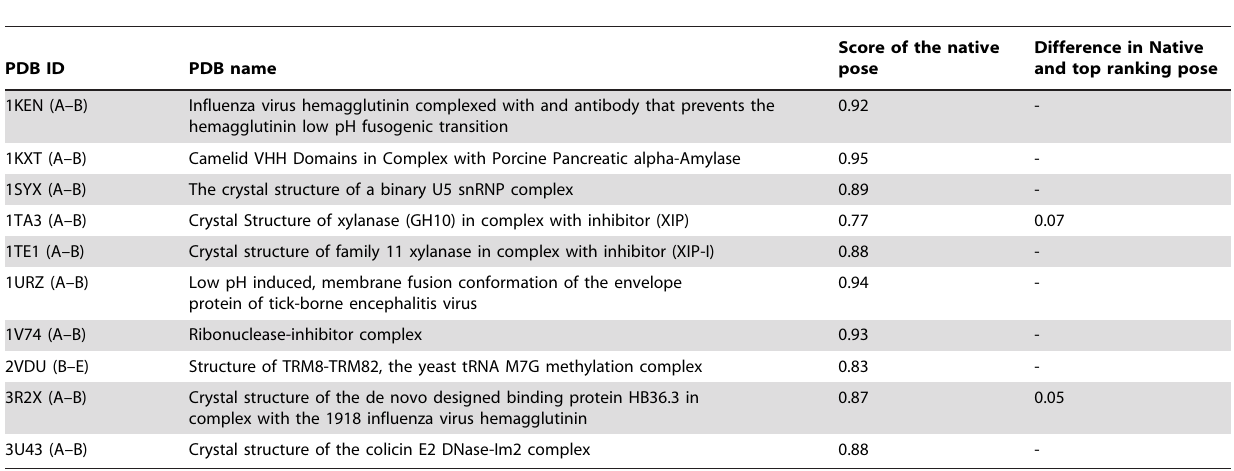
Table 6. List of 10 earlier CAPRI targets (with chain identifiers in parentheses) employed to evaluate DockScore performance.